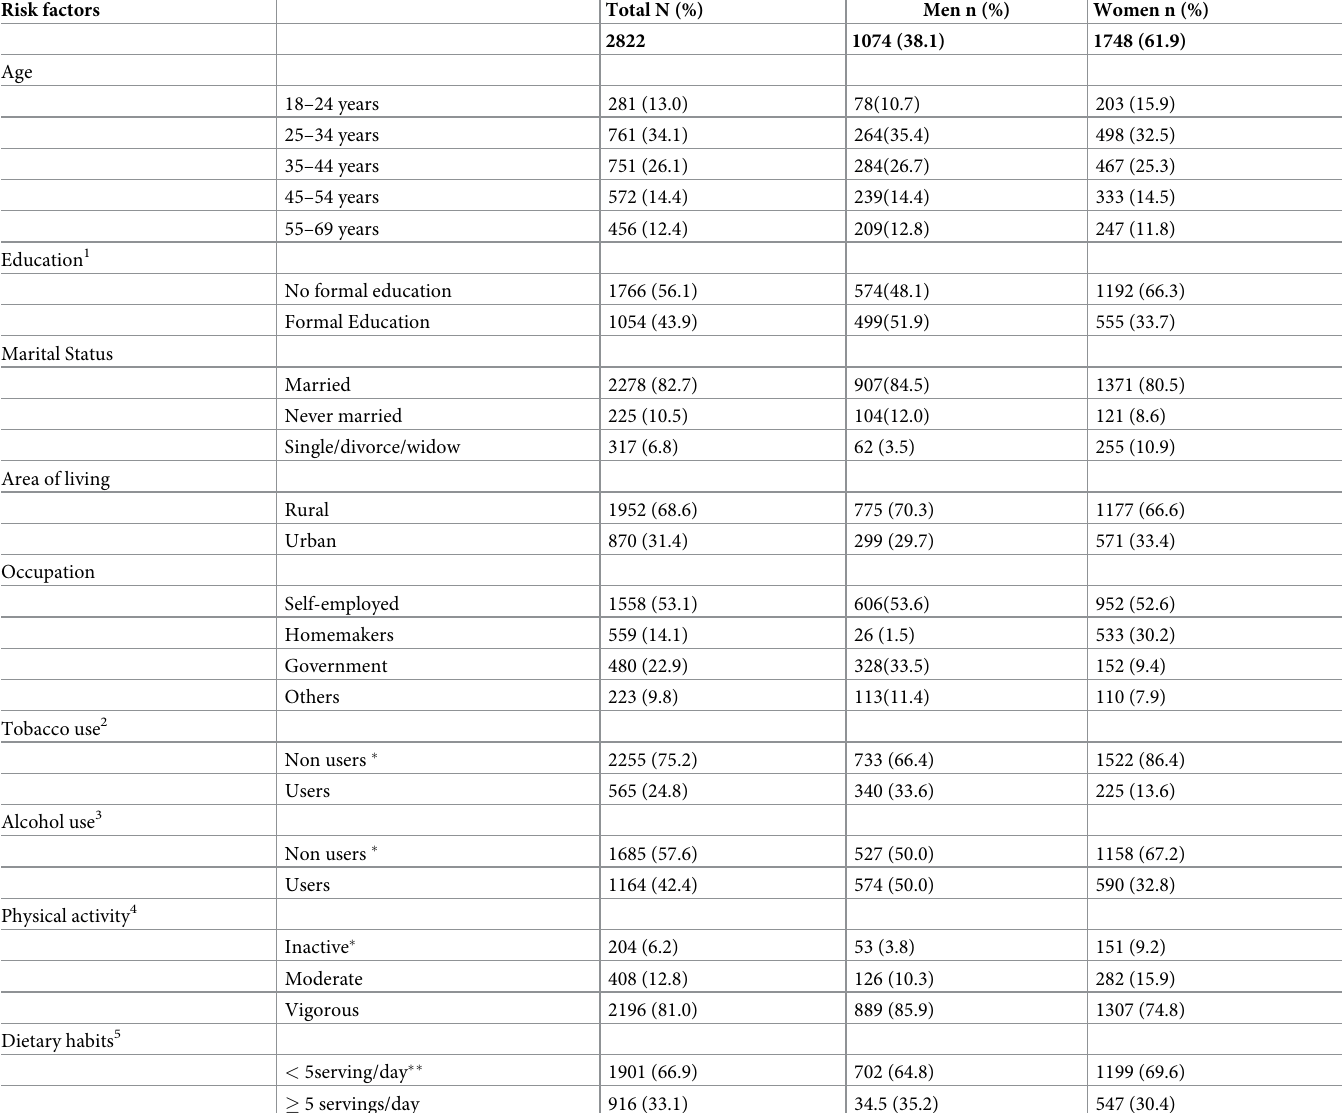
Table 1. Characteristics of the survey respondents and the prevalence of risk factors by